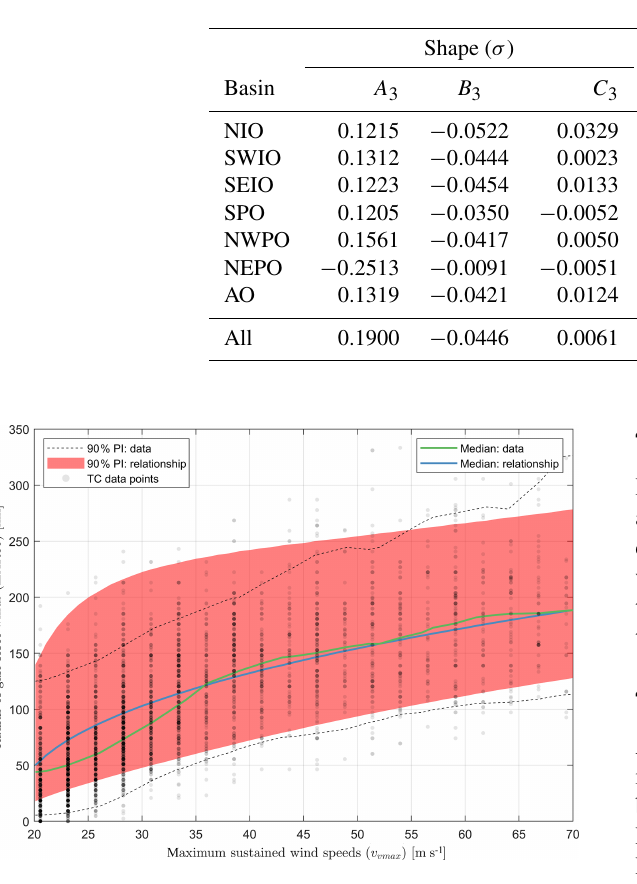
Figure 6. Scatter plot describing (cid:49) AR35 (BTD and computed, y axis) as a function of the maximum sustained wind speeds ( x axis; and the latitude; not shown). The blue line is the median of the pro- posed relationship derived for all basins at an arbitrarily chosen lat- itude of 10 ◦ . The green line is the median of the BTD. The red area shows the 90% prediction interval based on the proposed rela- tionship for the standard deviation. The 5% and 95% exceedance values from the BTD are presented as black solid lines. The gray dots are observation points in which more frequent observations are shown as darker points and less frequent observations as lighter